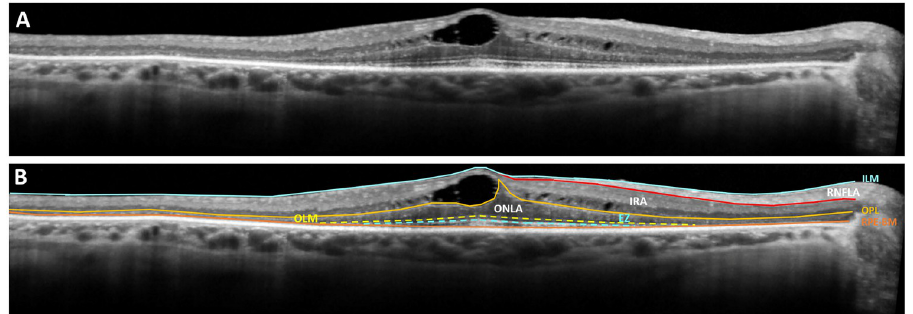
Fig 1. Manual segmentation and morphometric analysis of retinal layers. (A) Three horizontal OCT scans passing through the fovea were used for morphometric analyses. (B) The boundaries of the inner limiting membrane (straight blue line), the outer border of the retinal nerve fiber layer (red straight line), the mid-outer plexiform layer (orange straight line), and the inner border of the RPE-Bruch’s membrane complex (straight brown line) were traced manually. “ Retinal Nerve Fiber Layer Area” (RNFLA) was described as the area between the inner border of the internal limiting membrane and the outer border of the retinal nerve fiber layer. The area between the internal limiting membrane and the outer plexiform layer was defined as the “ Inner Retinal Area” (IRA), including the RNFLA and the cysts. Inner retinal neuronal area (IRNA) was defined as the area occupied by inner retinal neurons and estimated by subtracting the total cyst area and RNFLA from the IRA. The area between the outer plexiform layer and RPE was regarded as the “ Outer Retinal Area” (ORA). In the presence of cysts in the outer retinal zone, the cyst area was excluded from the outer retinal area calculation. The lengths of the intact OLM (interrupted yellow line) and EZ (blue interrupted line) were also traced and